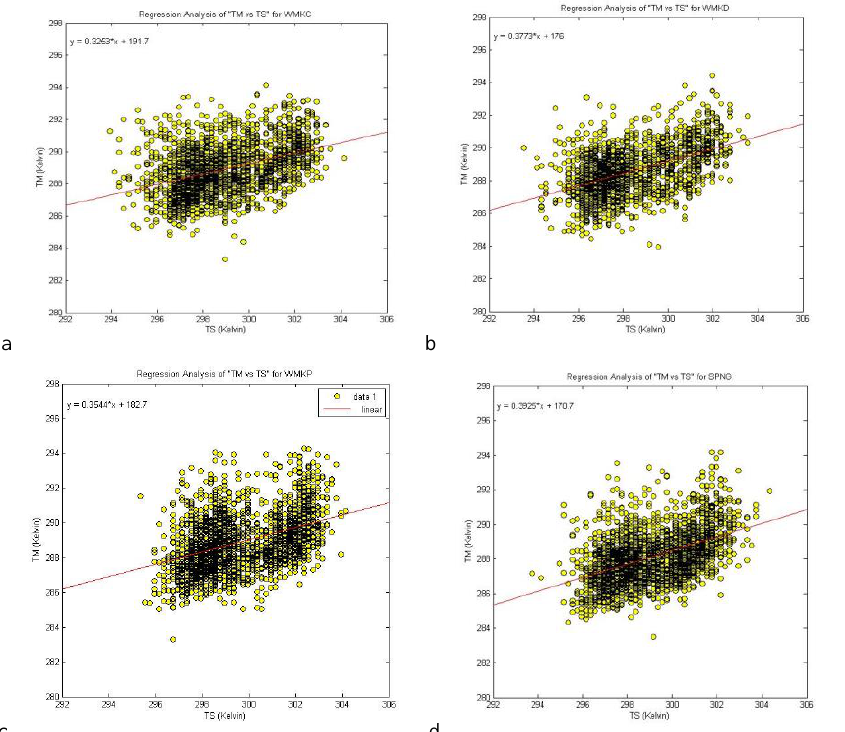
Figure 3. The site-specific T M model for each radiosonde station in Peninsular Malaysia. Scatter plot T M against T S show that the T M -T S relationship is <0.4 which indicates weak relationship at all radiosonde